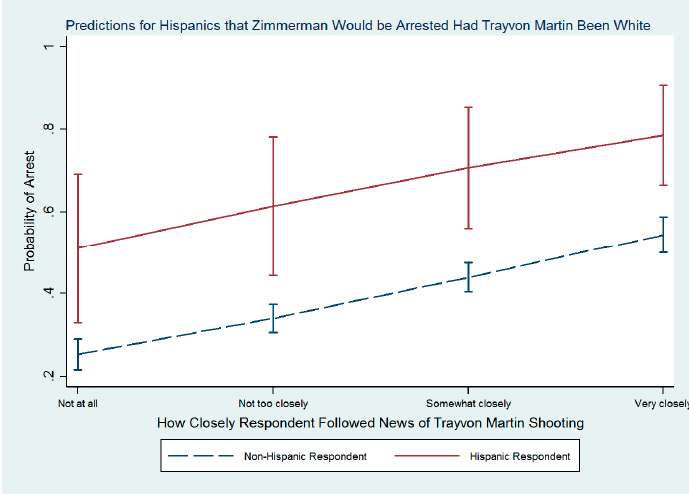
Figure 4. Perceptions of Injustice by Media Exposure among Hispanics and Non-Hispanics.